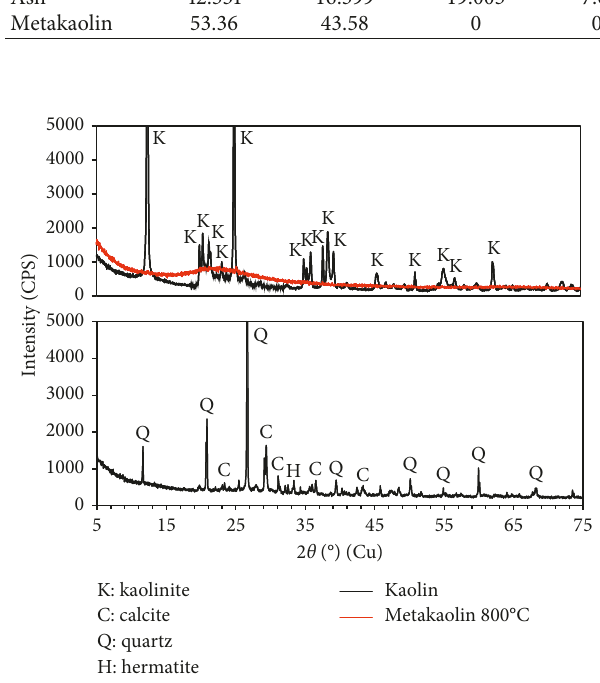
Figure 1: XRD of kaolin, of metakaolin, and of fly ash.